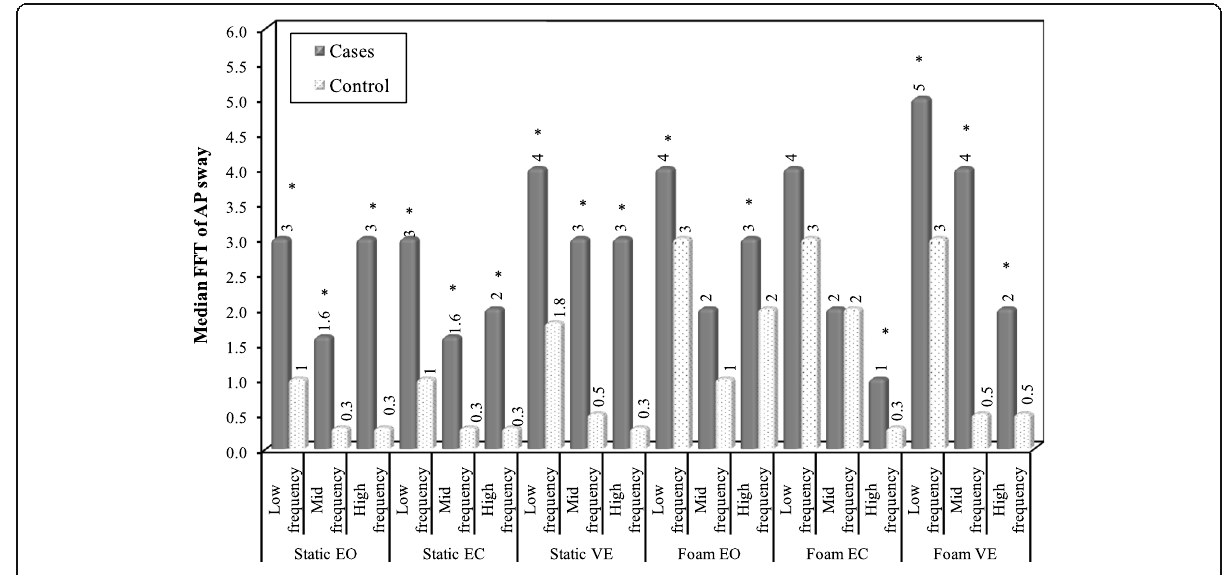
Fig. 1 Comparison of FFT of AP sway between cases and controls